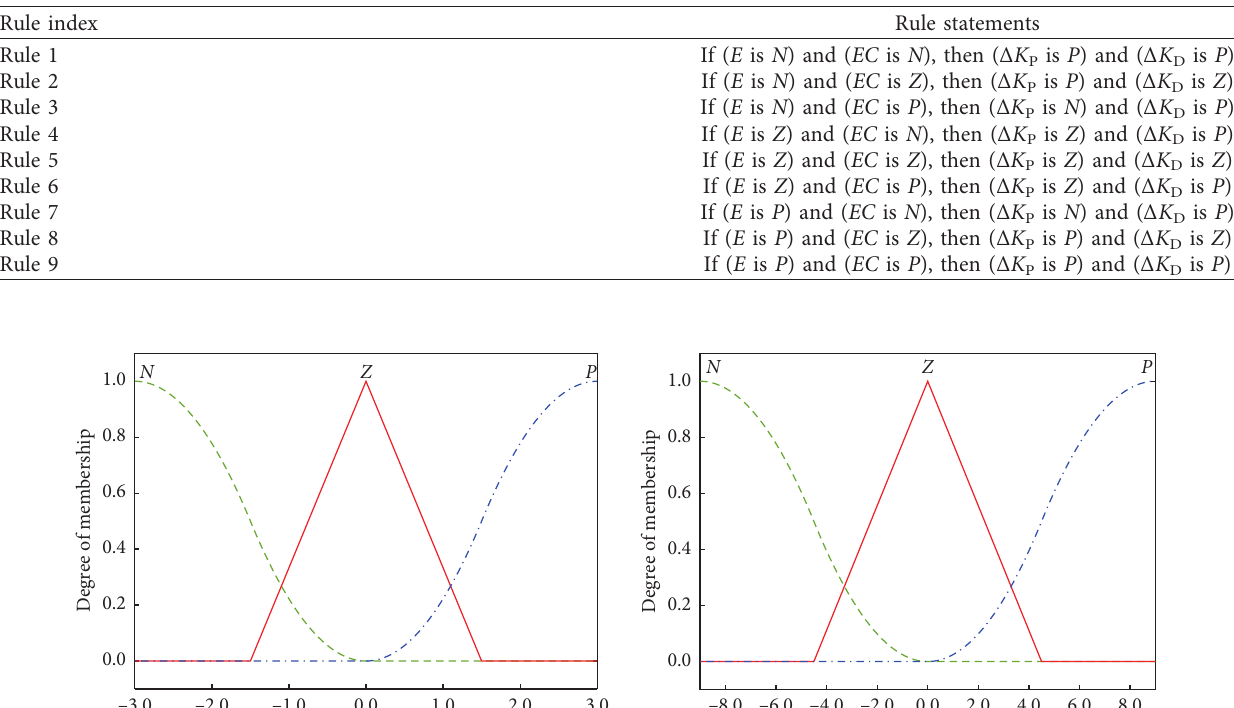
Table 3: Fuzzy rules of the fuzzy PD